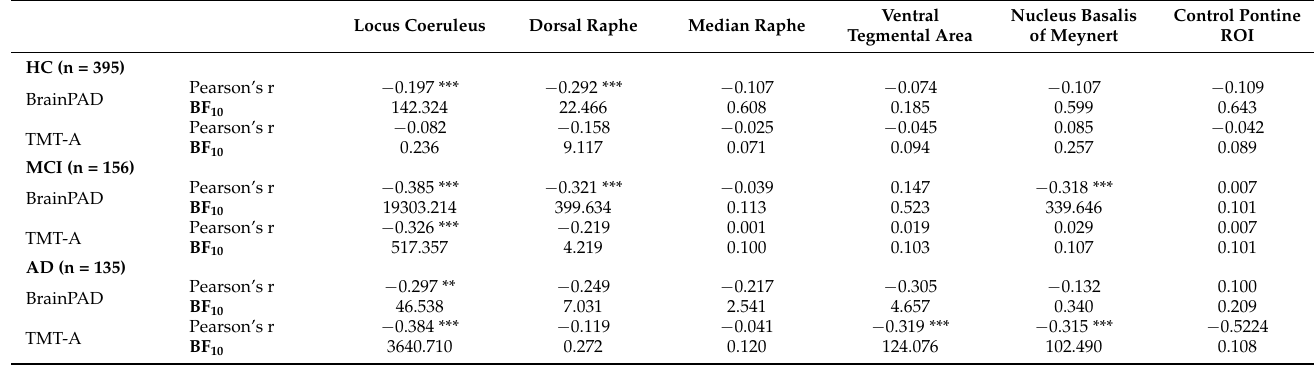
Table 4. The Bayes factors (BF 01 ) for the three groups showing the strength of relationships between the six ROIs, BrainPAD and TMT-A. ROIs average values were corrected for age, education and total intracranial volume. Locus Coeruleus Dorsal Raphe Median Raphe Ventral Tegmental Area Nucleus Basalis of Meynert Control Pontine